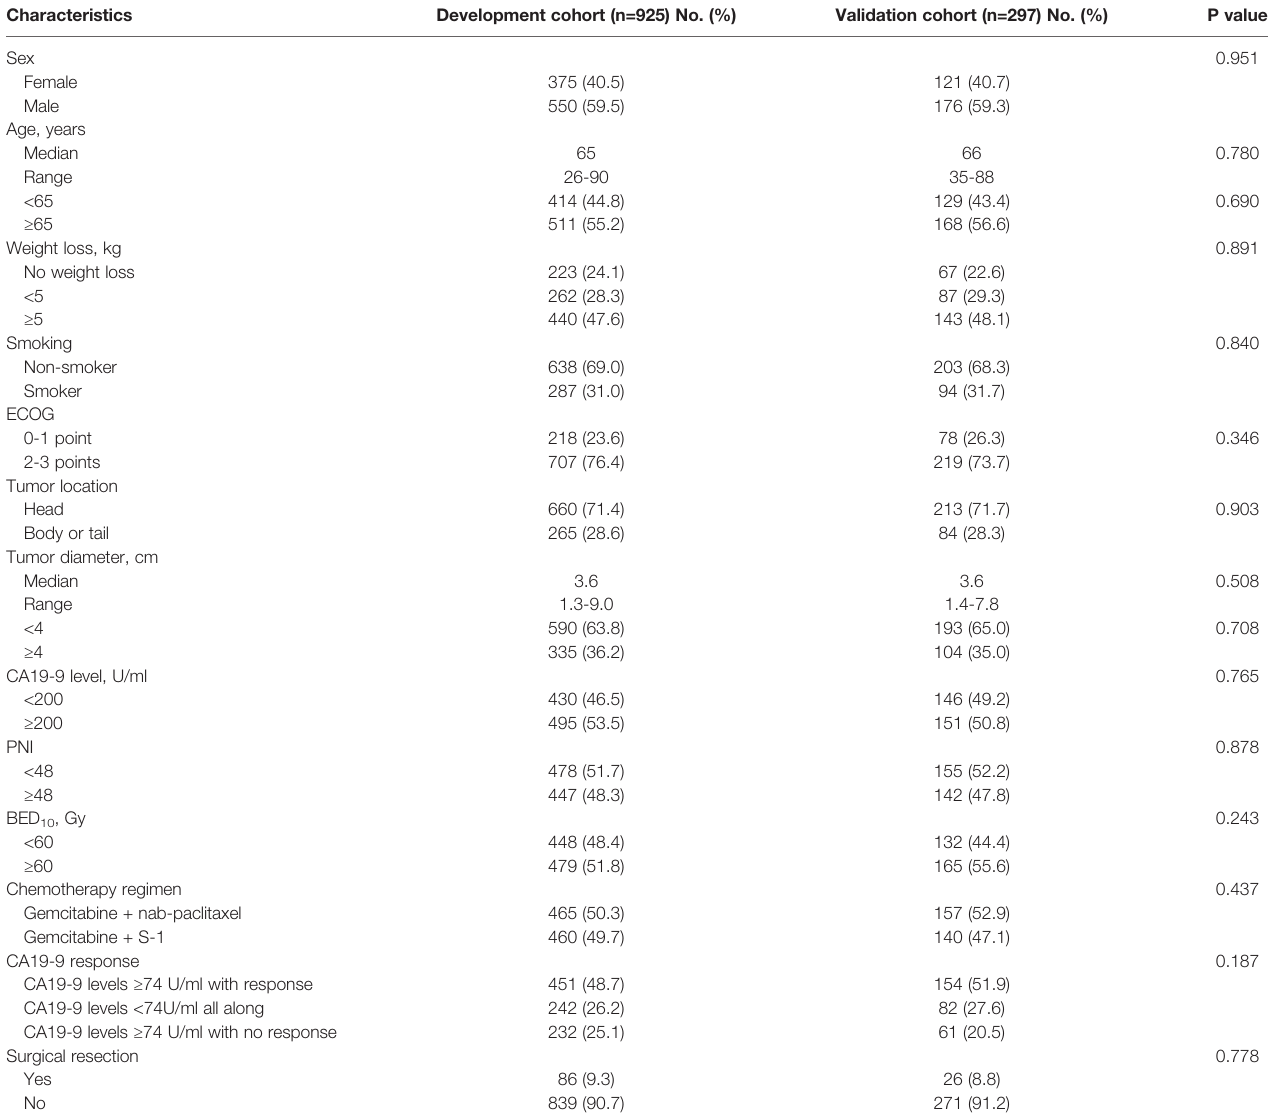
TABLE 1 | Baseline characteristics of development and validation cohort.